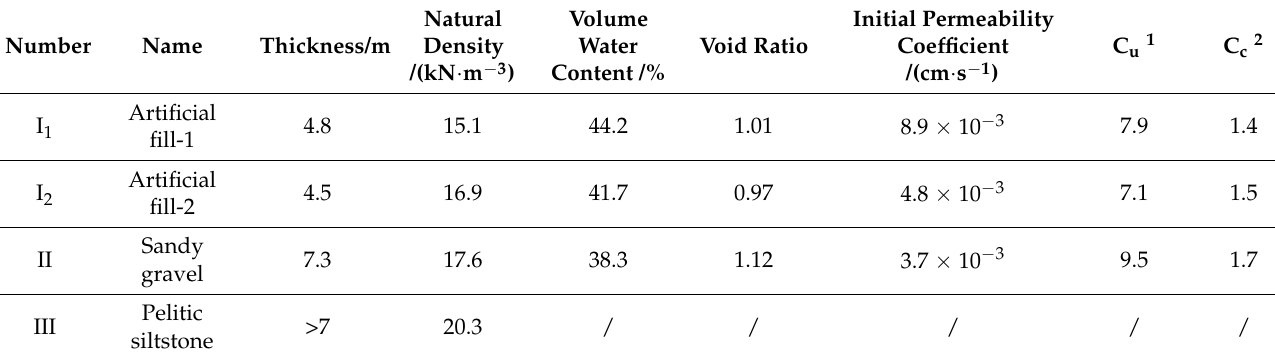
Figure 4. The geological cross section of typical section. Table 1. Physical and mechanical indexes of soil layer in the typical section.